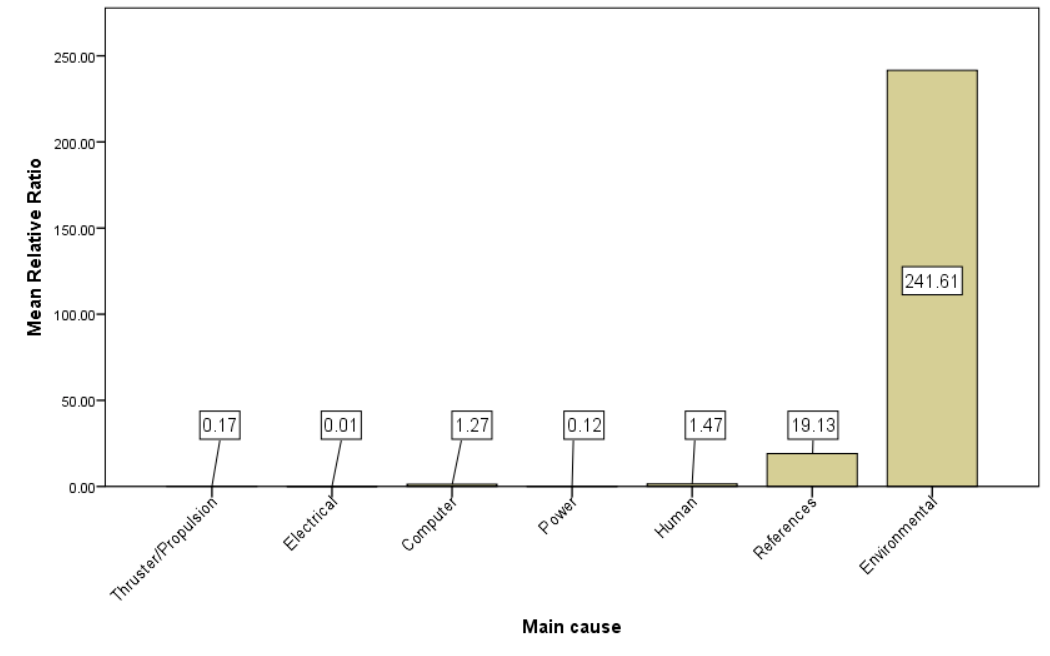
Figure 6. Mean relative ratio for each main cause